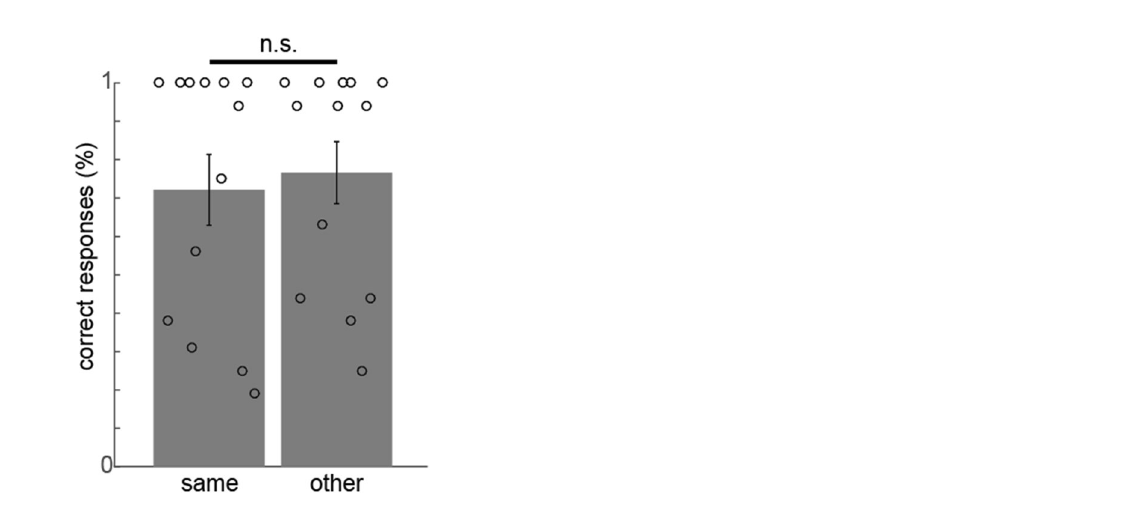
Figure 6. Results of the subsequent associative learning task. Average (± SEM) percentage of correct responses during the subsequent associative learning task, plotted separately for same category pairs and other category pairs (overlaid with individual responses). There was no significant difference between same and other category pairs’